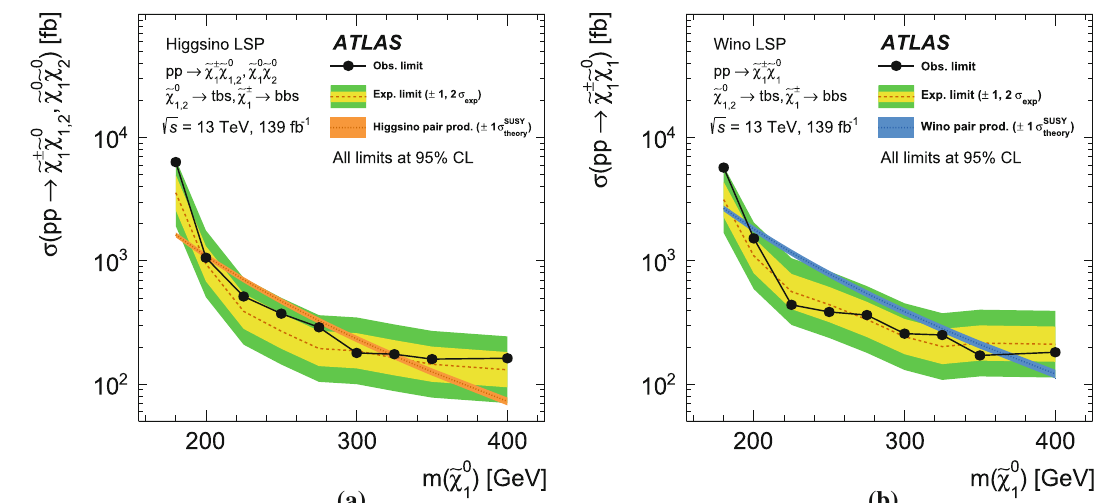
Fig. 10 Observed and expected exclusion contours for the RPV mod- els with electroweakino production models with a higgsino and b wino LSP hypotheses. The yellow and green contours of the band around the expected limit are the ± 1 σ and ± 2 σ variations including all uncer-